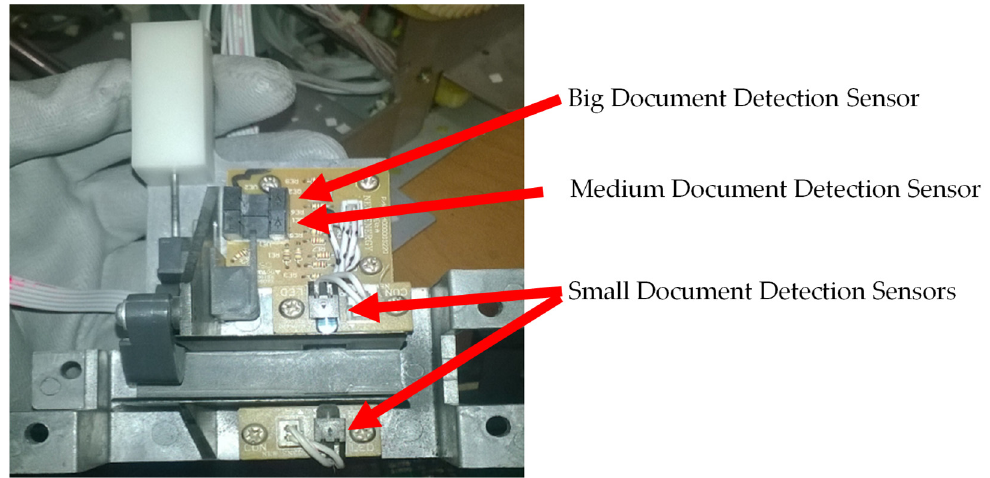
Figure 5. Document thickness measurement system showing which sensor indicates which size.